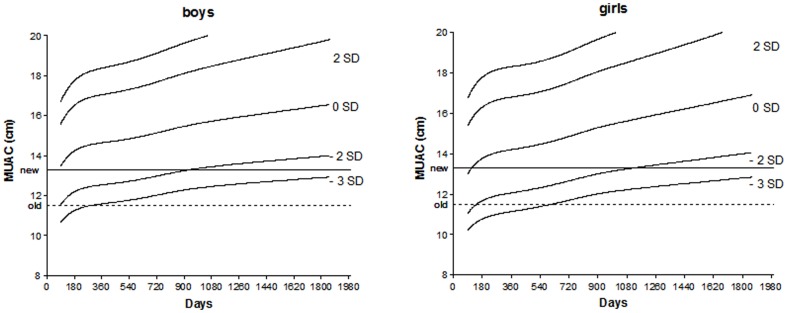
MUAC-for-Age Z-scores according to the gender (boys and girl) from WHO anthropometric database in comparison to a single cut-off of 13.3 cm.